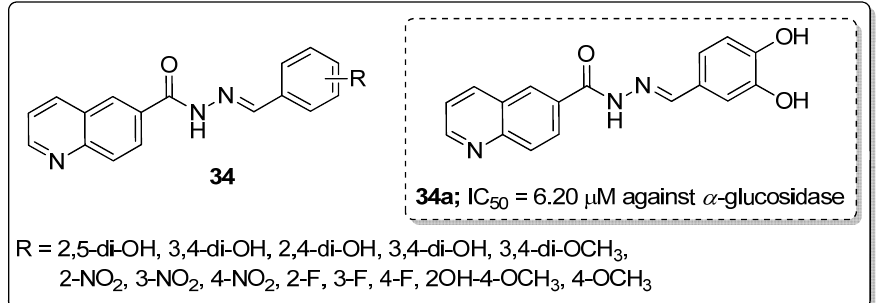
Figure 39. The m ost active quinoline with Schiff base analog 34a as an α ‐ glucosidase inhibitor. Hybrid molecules 35 having quinoline, pyrazole and thiazole moieties were synthesized and evaluated for their antiproliferative activity [91]. Among them, the hybrid 35a with a para ‐ fluoro